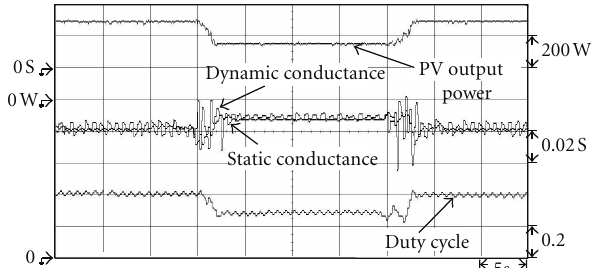
Figure 15: Measured output power, dynamic conductance, static conductance, and duty cycle waveforms of a PV module array using the traditional INC method under irradiation that dropped from 1,000 W/m 2 to 700W/m 2 and then increased back up to 1,000 W/m 2 .